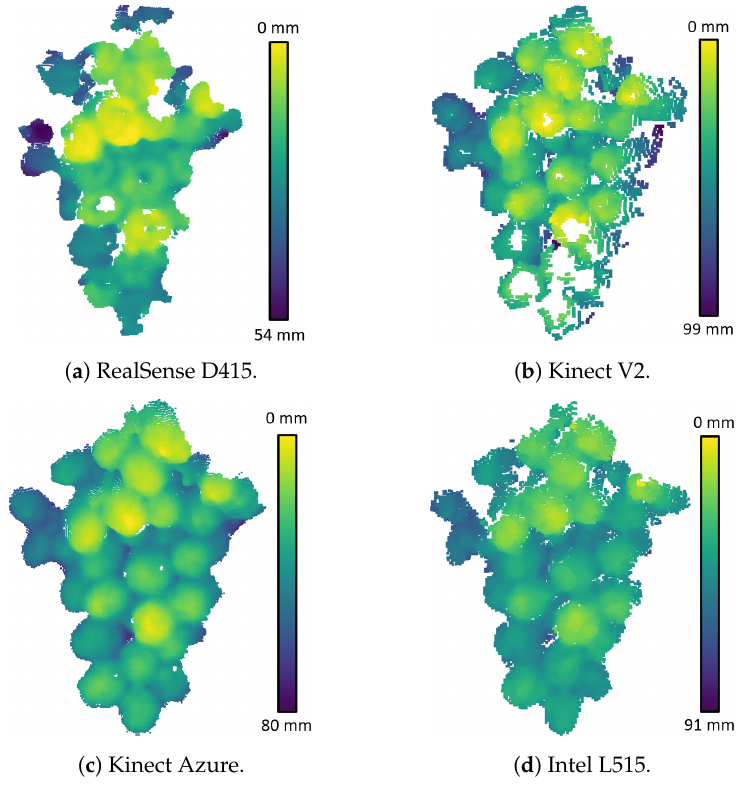
Figure 13. Depth scans for the RGB-D cameras captured outdoors at a distance of 600 mm from the grape